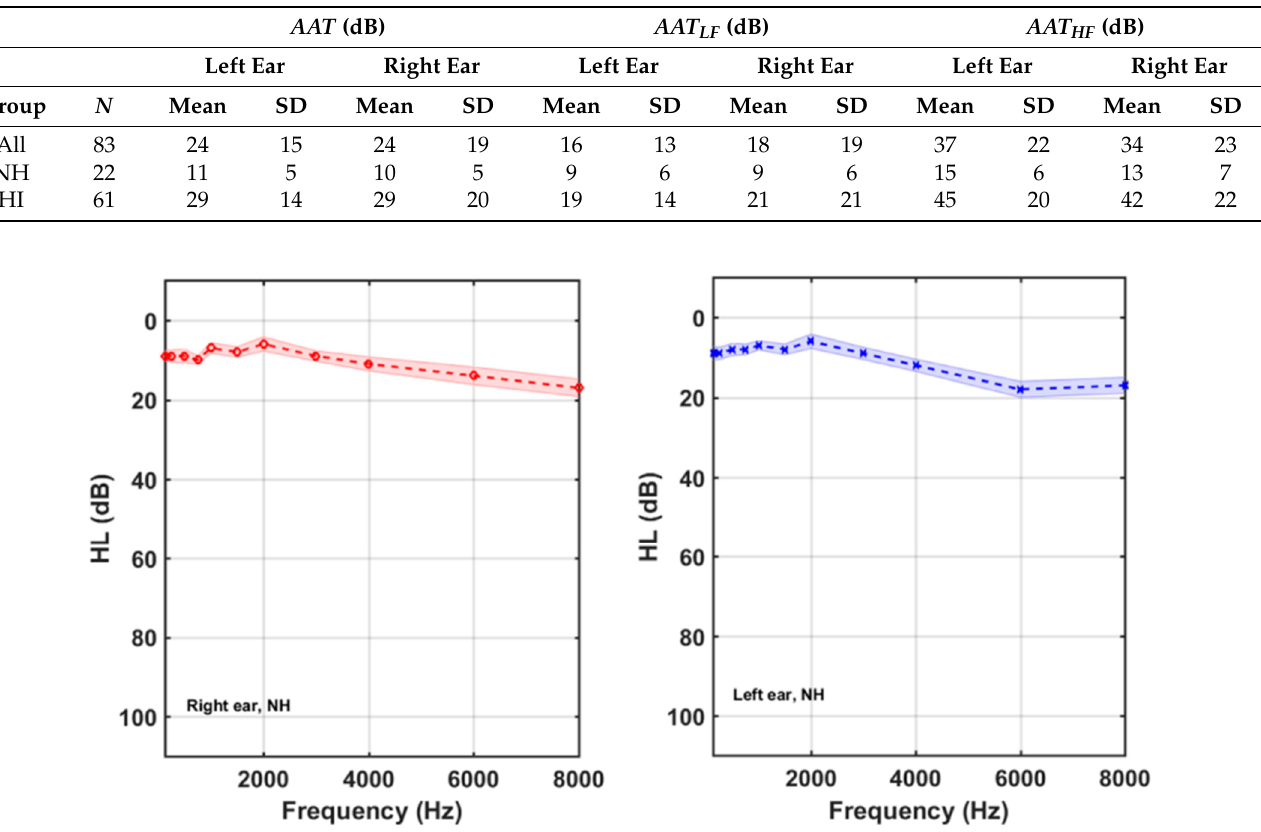
Figure 3. Right and left average audiograms of the 22 participants of the NH subgroup. Shaded areas around the mean curves display the 95% confidence intervals.